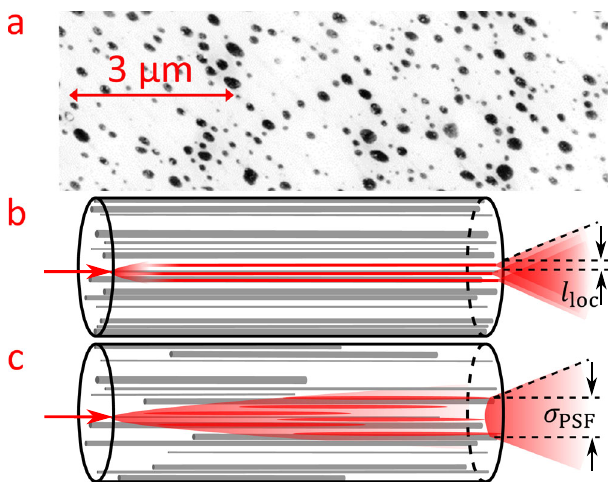
Fig. 2 Phase-separated fi ber: contrast image and schematic propagation through Anderson localized modes. a Contrast image of a cross-section of a phase-separated fi ber (PSF) sample, with matrix glass (in white) and strands (in black). The distribution of particle diameters is roughly Poissonian. The disorder in refractive index leads to the formation of localized modes. b Schematic of light propagation in an ideal PSF cane, where the axially invariant modes (red horizontal lines, with localization length l loc ) are the main guiding channels. c Propagation in real PSF, where light is partially diffused, hopping between localized modes, which change adiabatically due to longitudinal discontinuities (here exaggerated). The output of the PSF then reaches a size σ PSF